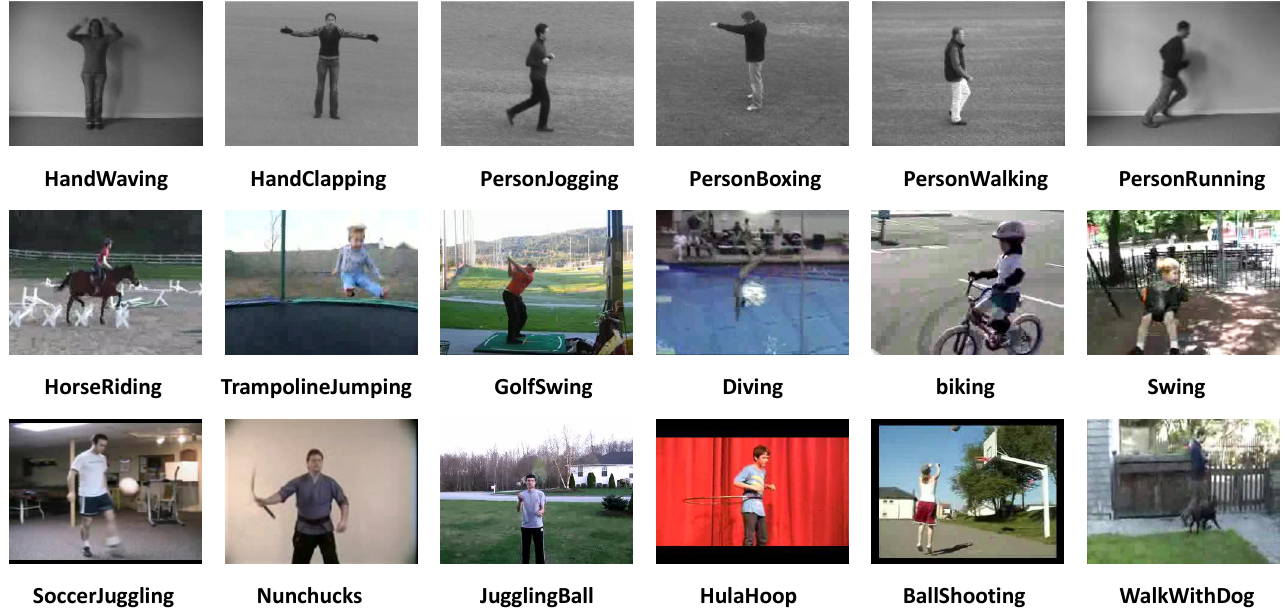
Figure 16. Sample frames from the three action recognition datasets in our experiments. From top to bottom: KTH, YouTube, and